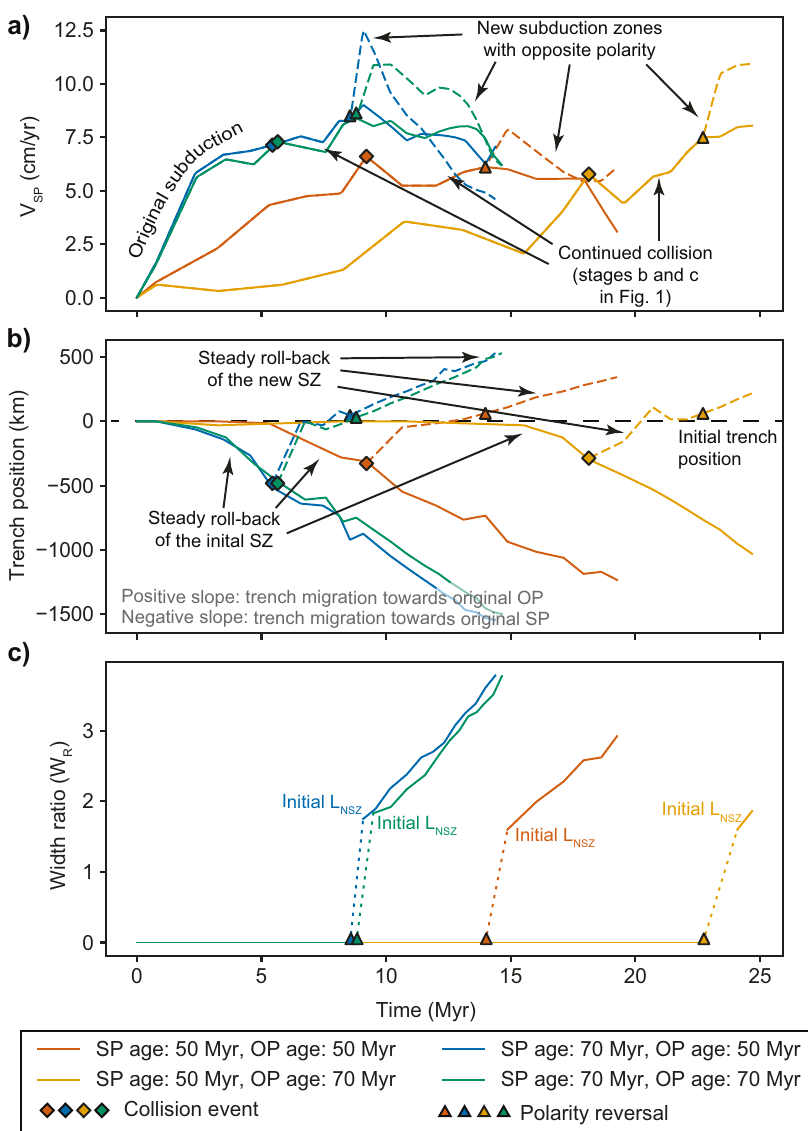
Fig. 4 Graphical depiction of the evolution of the model monitored parameters for the different considered (initial) plate age contrast between the overriding and the subducting plates (OP and SP age respectively). Coloured diamonds and triangles, as well as V SP measurements, with the same meaning, and obtained in the same way, as explained in the caption of Fig. 3. a Evolution of subduction plate velocity ( V SP ) over time (subduction plate acceleration), for the original subduction zone (full lines), and for the newly formed opposite dipping one (dashed lines). Note that older subducting plates show faster evolutions, expressed by the steeper variations over time, derived from their higher negative buoyancy and effective slab pull (see Supplementary Table 4). b Subduction trench migration as a function of time (trench velocity), for the original subduction zone (full lines) and for the newly formed subduction trench (dashed lines). The plateau collision event causes an abrupt migration of the trench towards the overriding plate (OP). Younger subducting plates show longer time gaps between plateau collision and the polarity reversal event. c Plateau indentation ef fi ciency, expressed by the time evolution of the W R ratio (see Supplementary Fig. 1B and caption of Fig. 3c). As no new subduction zones are formed before the collision of the plateau with the overriding plate, W R values prior to this event are always zero. Despite the fact that older subducting plates trigger polarity reversal at earlier stages, plate age appears to have no relevant in fl uence on the effectiveness of plateau indentation (expressed by a similar steepness of all the curves). SZ subduction zone, OP overriding plate, SP subducting plate, L NSZ length of the new subduction